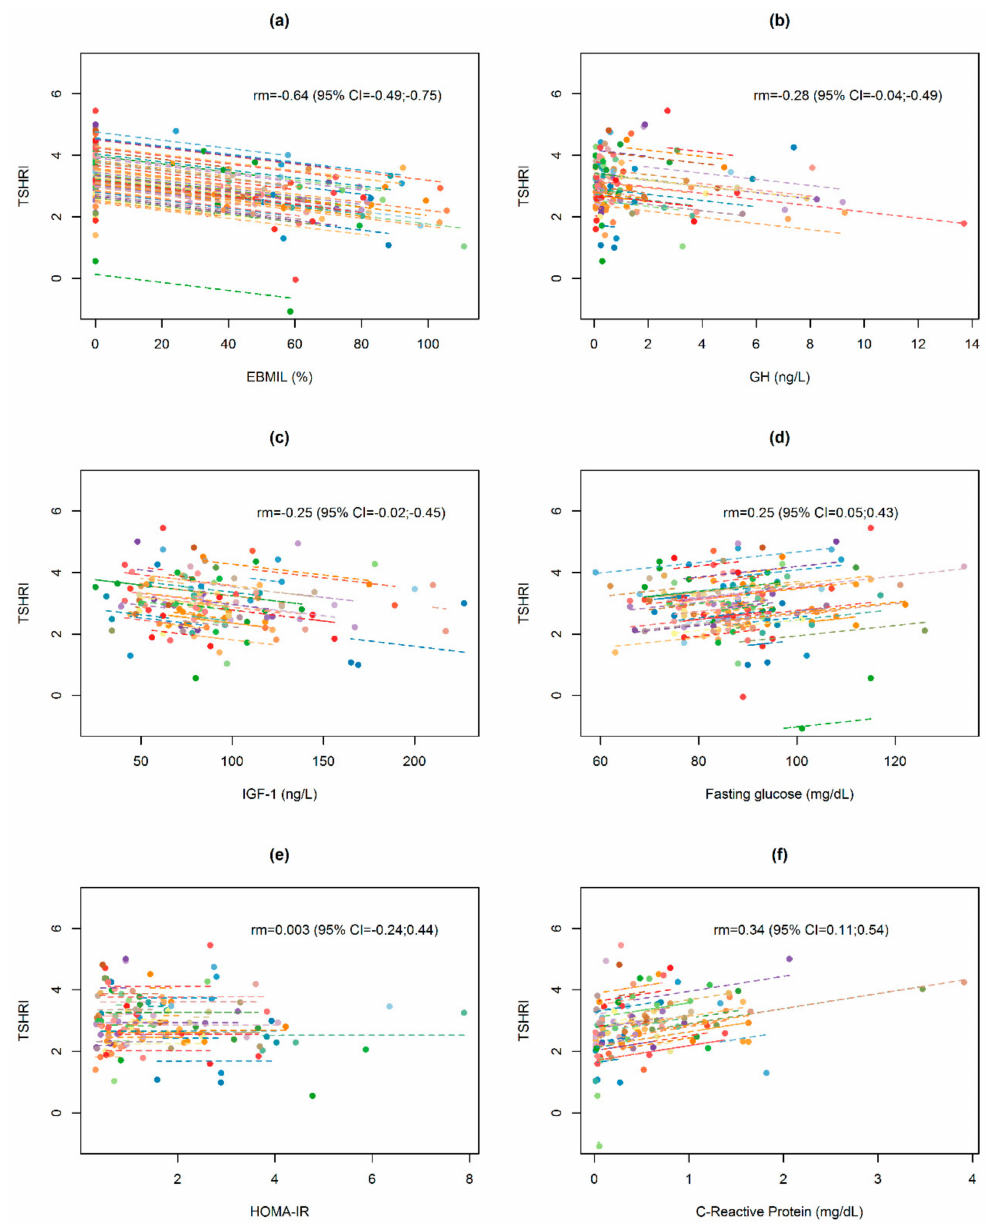
Figure 3. Repeated measures correlation for the overall relationship between changes in TSH resistance index (TSHRI) and ( a ) excessive BMI loss in percentage (EBMIL), ( b ) GH, ( c ) IGF-1, ( d ) Fasting glucose, ( e ) HOMA-IR and ( f ) C-reactive protein. Obese subjects ( n = 106) are represented by dots than correspond to basal and postoperative TSHRI values and the respective anthropometric, biochemical, and hormonal data. Each line represents the repeated measures correlation fit for each